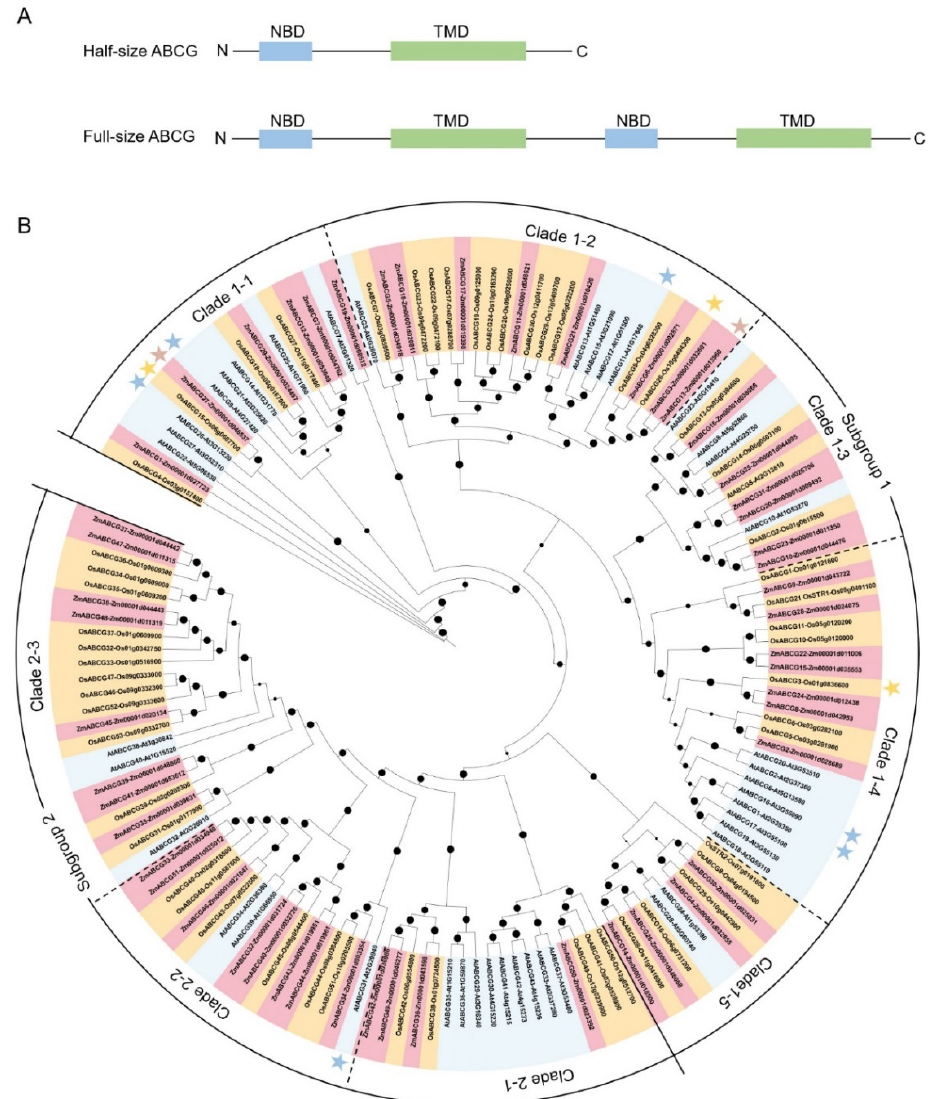
Figure 2. Phylogenetic analysis of ABCGs in maize, rice and Arabidopsis . ( A ) Gene structures of half-size and full-size ABCG. NBD, nucleotide binding domain; TMD, transmembrane domain; ( B ) Phylogenetic analysis of ABCGs in maize (51), rice (54) and Arabidopsis (43). Subgroup 1 contains 90 half-size ABCGs, including 31 in maize, 31 in rice and 28 in Arabidopsis . Subgroup 2 consists of 58 full-size ABCGs, including 20 in maize, 23 in rice and 15 in Arabidopsis . Subgroups 1 and 2 can be classified into 5 and 3 clades, respectively. Stars indicate the ABCGs involved in male sterility.